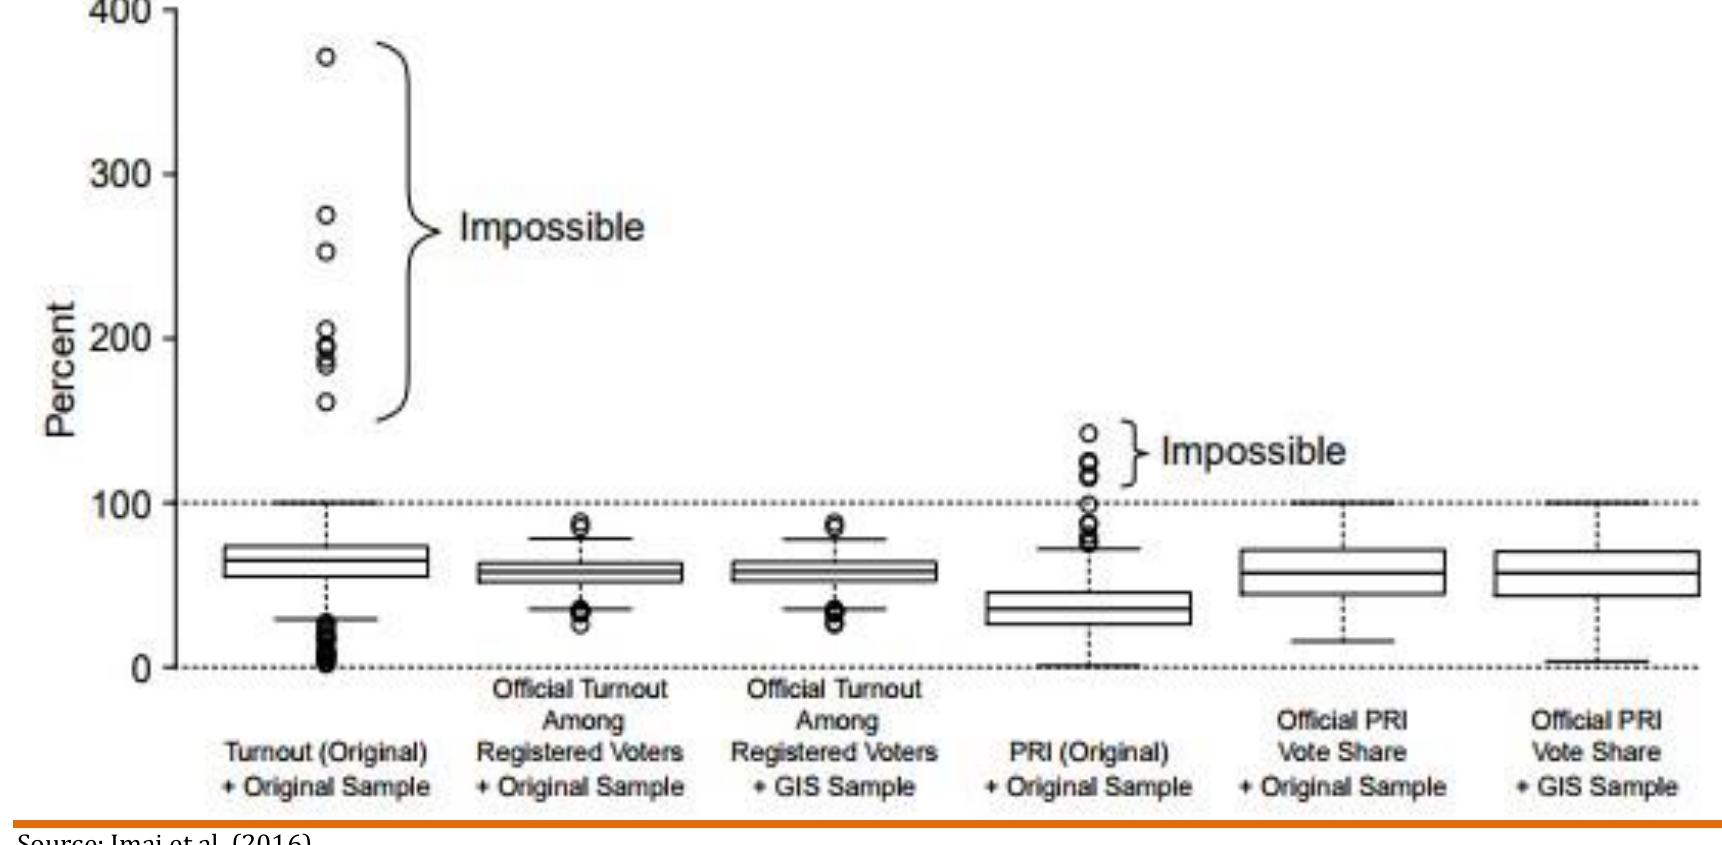
Source: Imai et al.